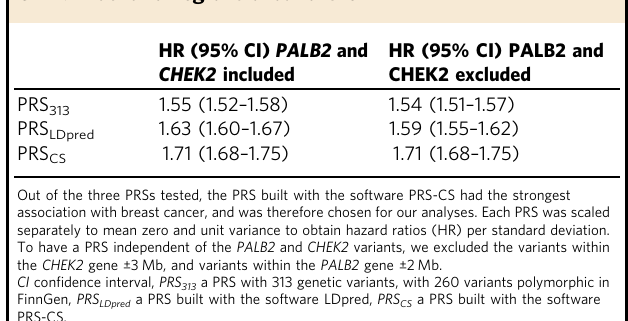
Table 1 Comparison of effect sizes for three polygenic risk scores (PRS) with and without excluding the PALB2 and CHEK2 loci and regions around